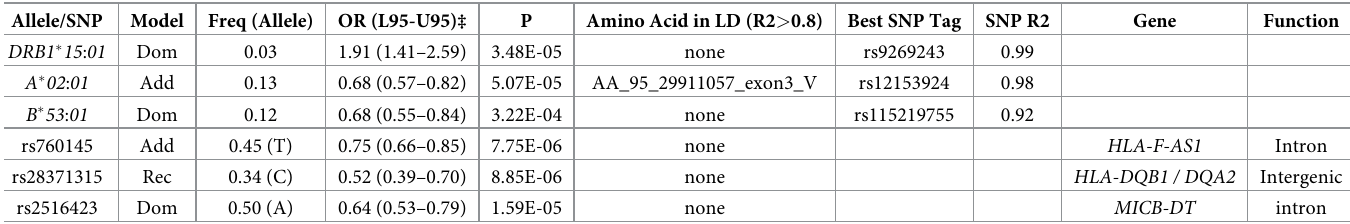
Table 2. Independent classical HLA alleles and SNPs in African Americans.